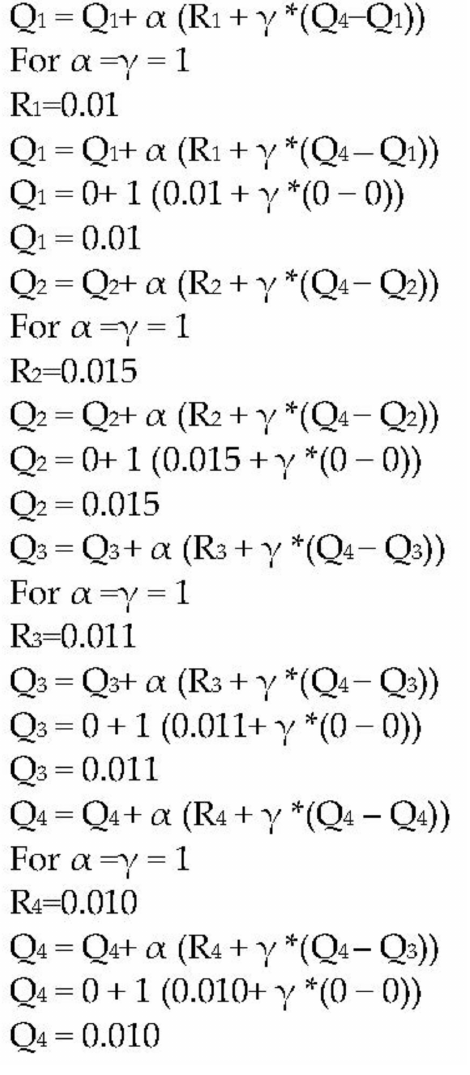
Figure 6. Reinforcement learning (Q Learning)